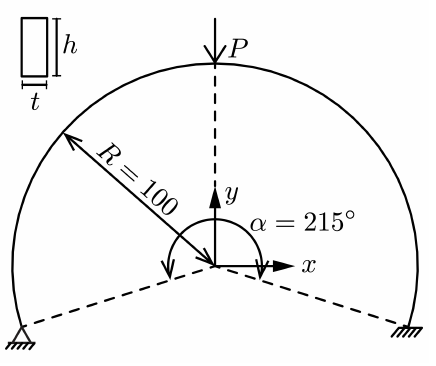
Figure 5. Circular arch geometry.